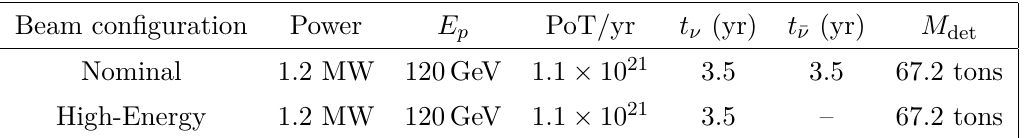
Table 2 . Exposure and beam configuration parameters used in the simulations. From left to right, the columns indicate beam power, proton energy, number of protons on target per year (PoT/yr), the running times in neutrino and antineutrino modes, and the fiducial mass of the detector. Indeed, NU can be considered a particular case of NSI in production and detection.